Question: Which visualization type does this figure use?
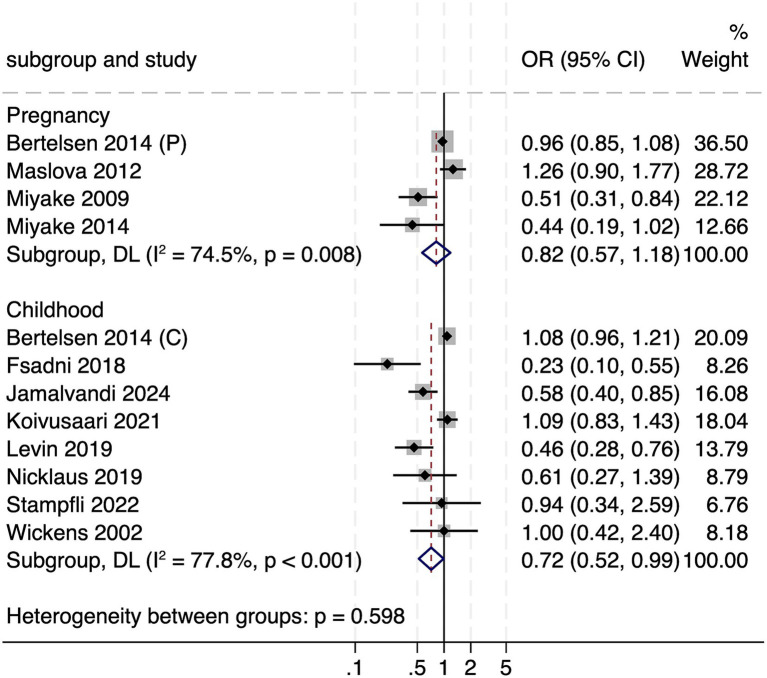
Answer: forest